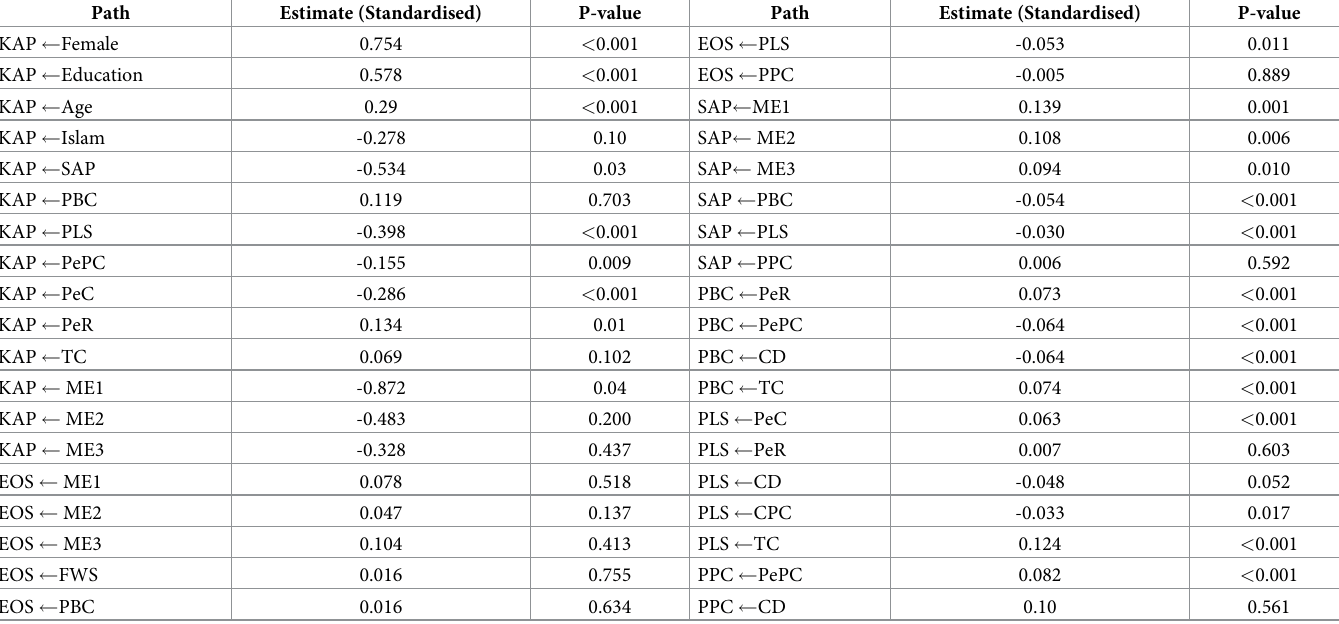
Table 3. Result of simultaneous equation model of contextual factors with knowledge about puberty.